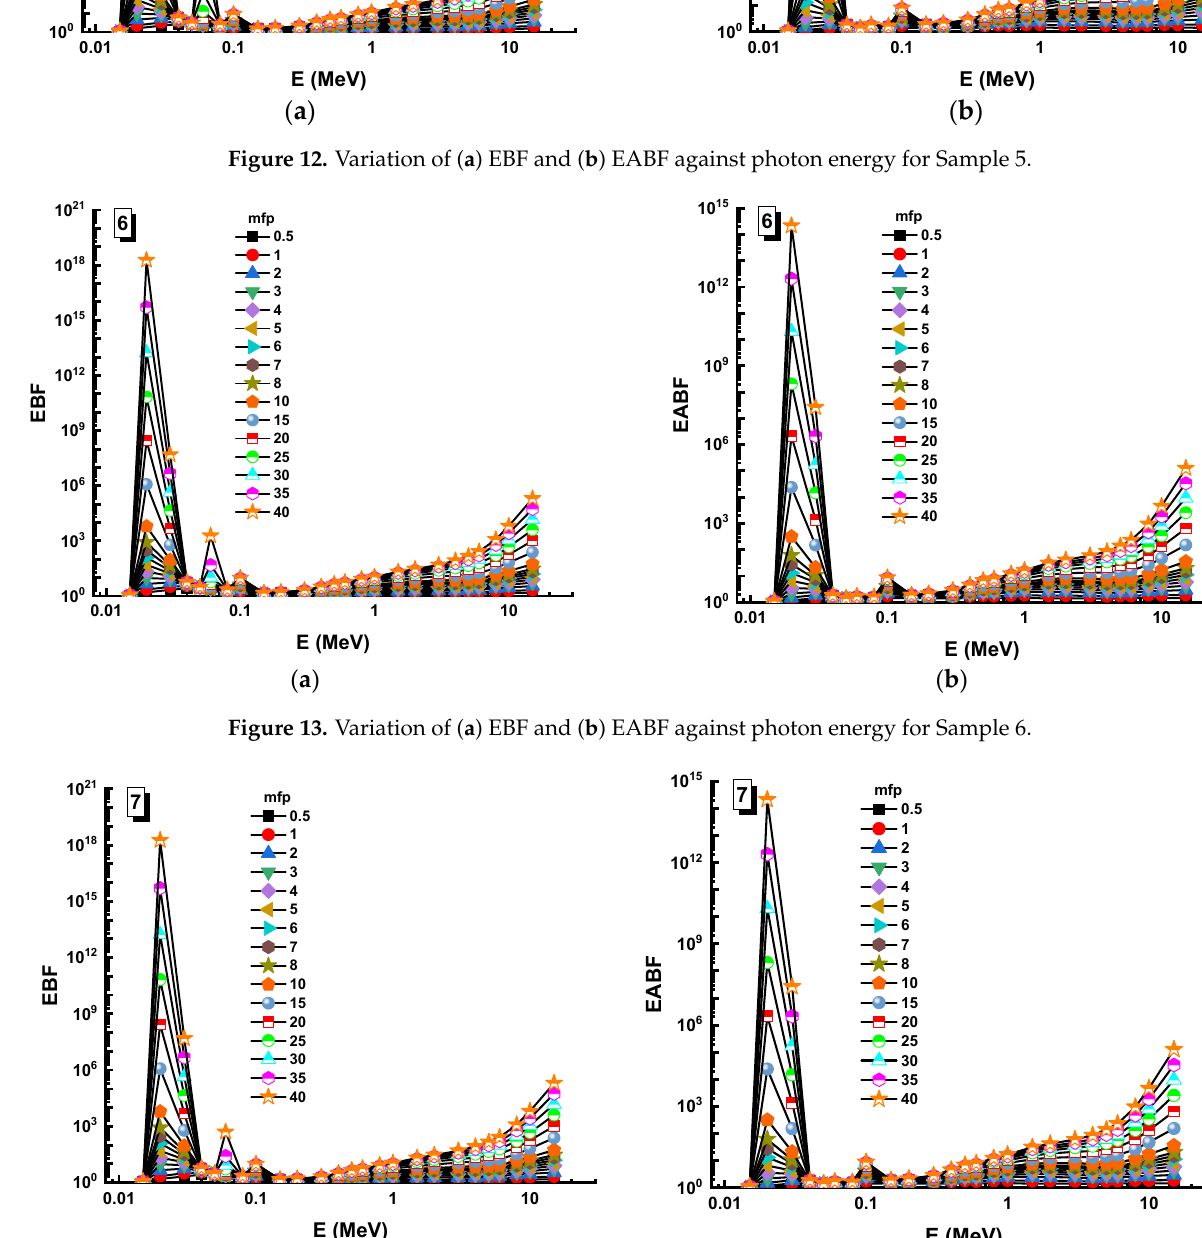
Figure 14. Variation of ( a ) EBF and ( b ) EABF against photon energy for Sample 7.